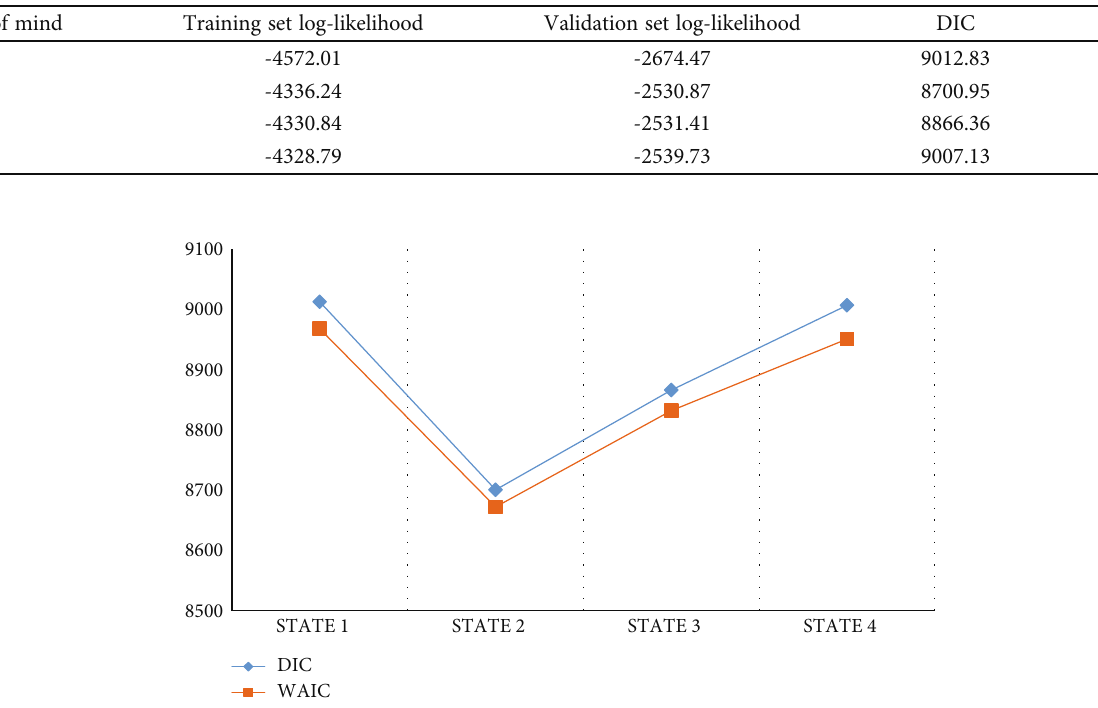
Figure 9: DIC and WAIC estimation results.